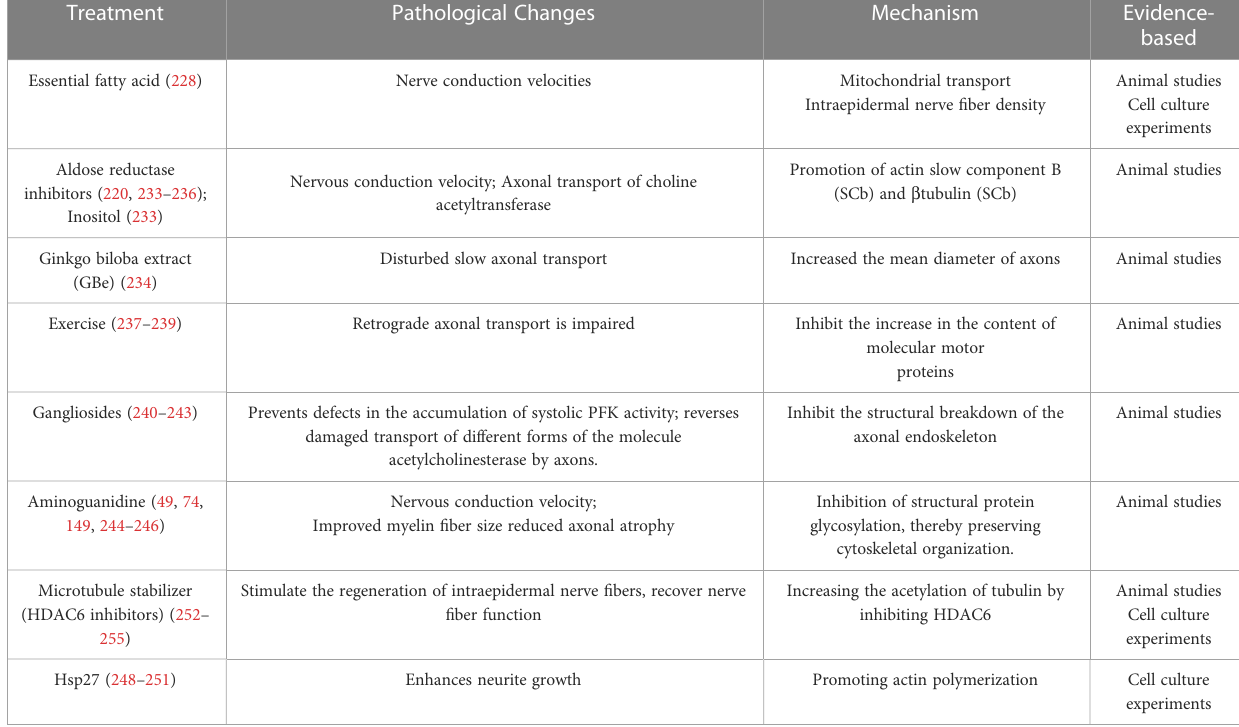
TABLE 1 Potential therapeutic approaches to improve axonal transport mechanisms in diabetic peripheral